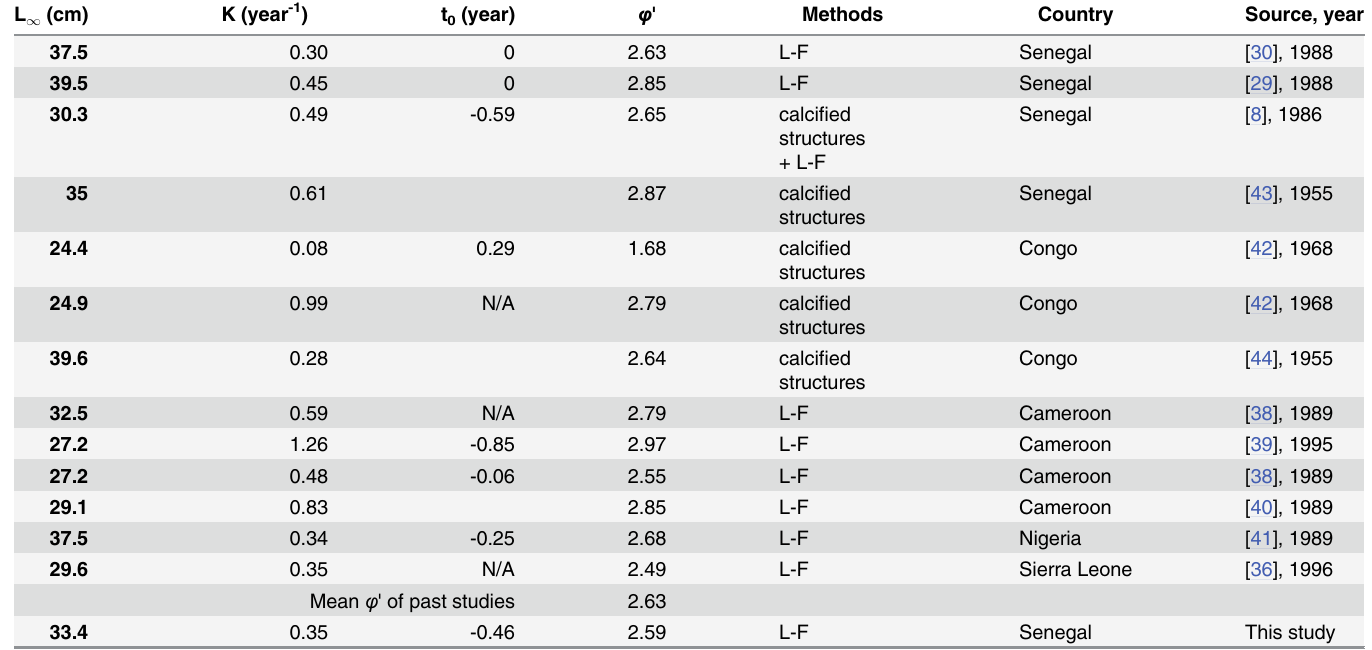
Table 3. Growth parameters of Sardinella maderensis , based on the results of various publications in West Africa. N/A means not available; L-F means length-frequencies. The length is expressed as fork length. L 1